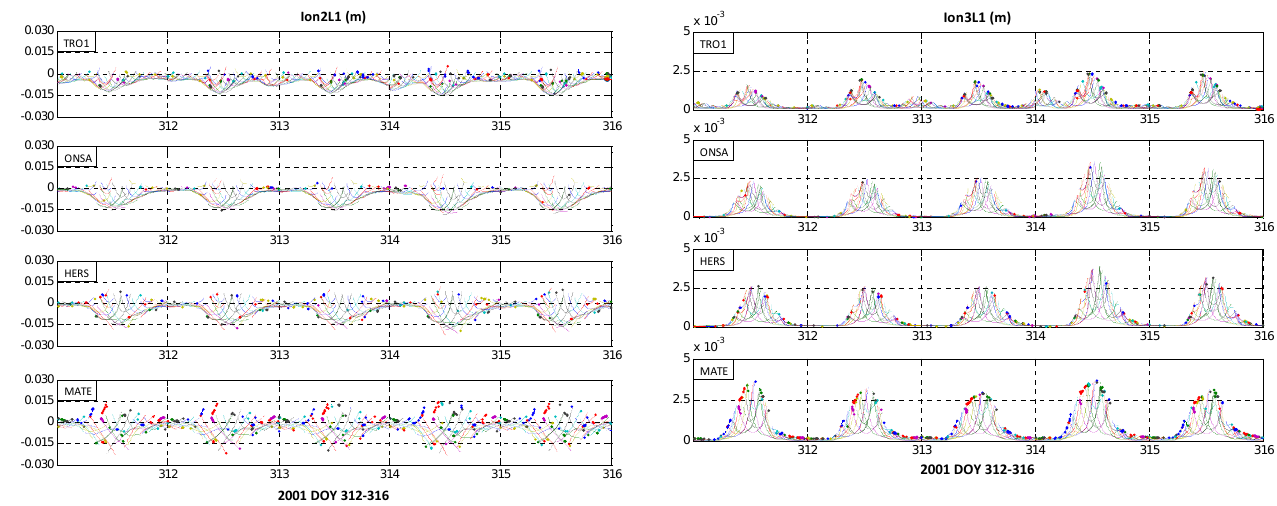
Fig. 4. Ion3 (m) for GPS L1 (Ion3L1) for the observation stations on DOY 312‐316 in 2001.